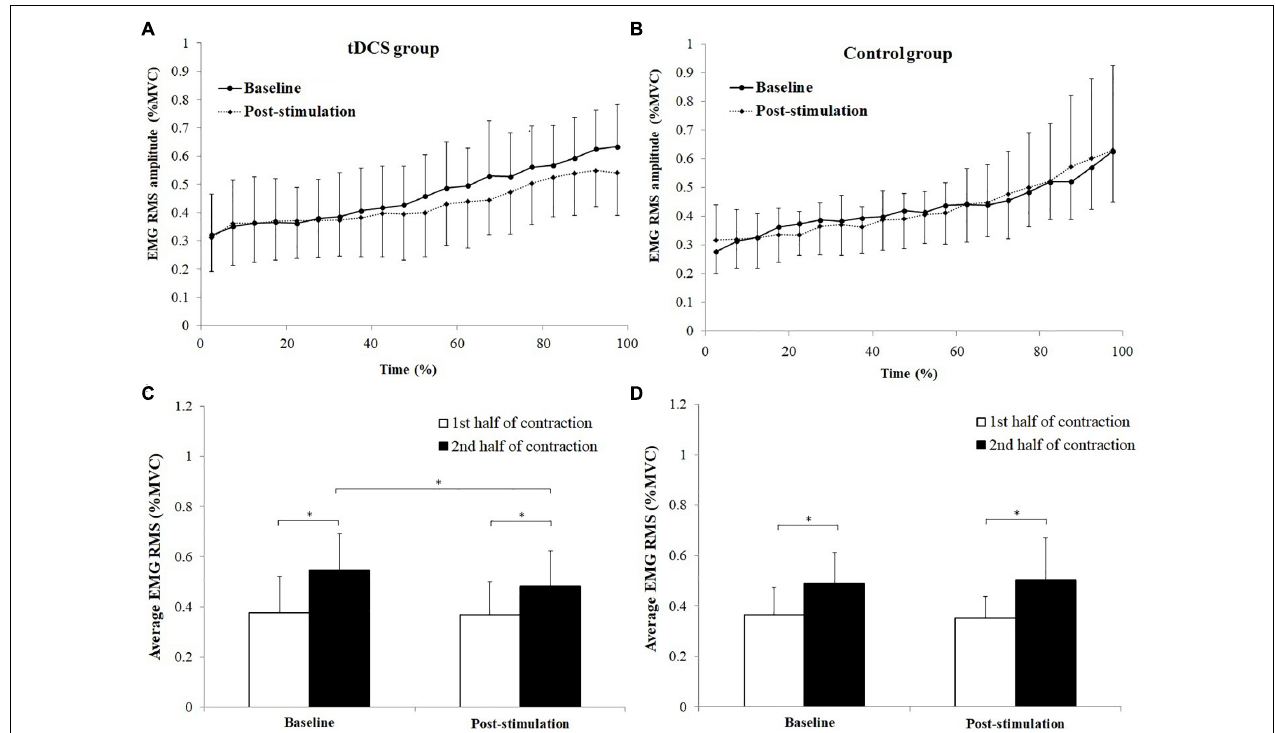
FIGURE 5 | Changes of biceps brachii (BB) muscle activation levels during the sustained fatiguing elbow flexion contraction (A,B) and comparisons of average electromyography (EMG) root mean square (RMS) [% maximum voluntary contraction (MVC)] between the 1st and 2nd half of contraction for baseline and post-stimulation test in transcranial direct current stimulation (tDCS) (C) and control (D) group subjects. Data have been expressed as mean ± SD values. *demonstrated a significant difference of observed index between the baseline and post-stimulation test or between the 1st and 2nd half of contraction. stimulation × fatigue × group ( F = 5.94, P = 0.024,